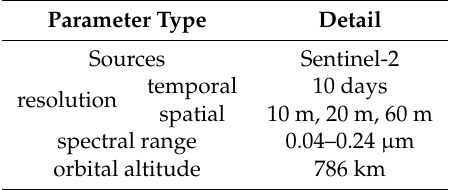
Table 1. Detailed information for Sentinel-2 satellite